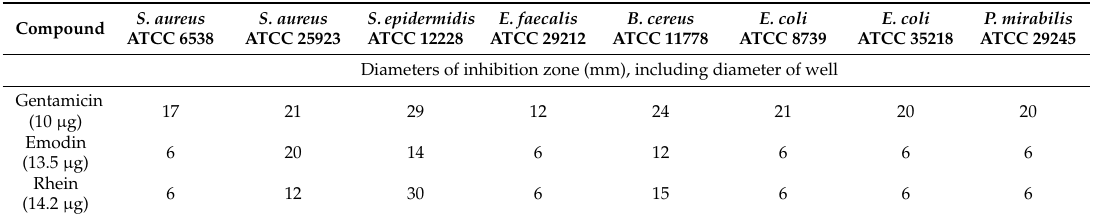
Table 2. Antibacterial activity of the tested compounds ascertained by the well diffusion method. Compound